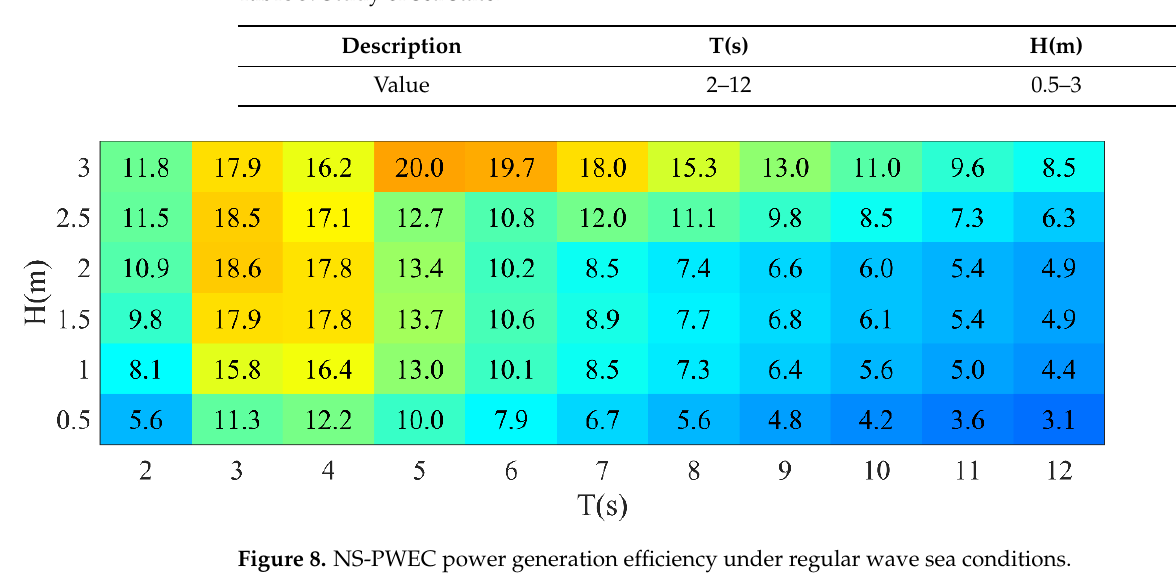
Figure 7. Power output of S-PWEC and NS-PWEC.